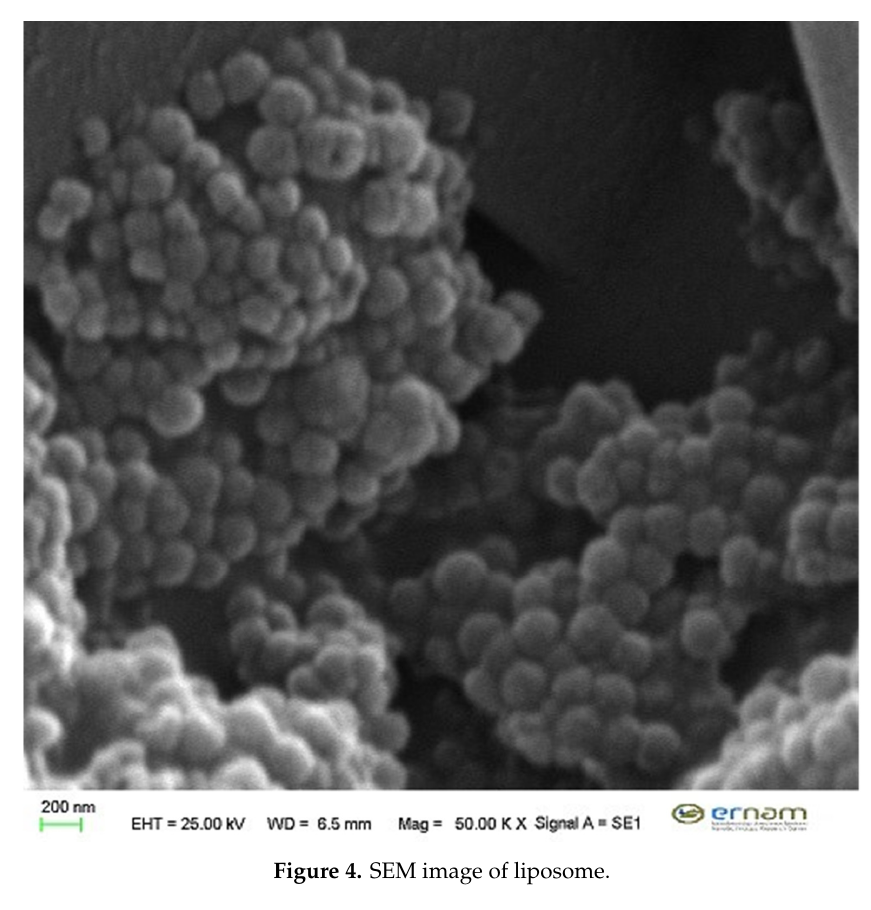
Figure 4. SEM image of liposome.